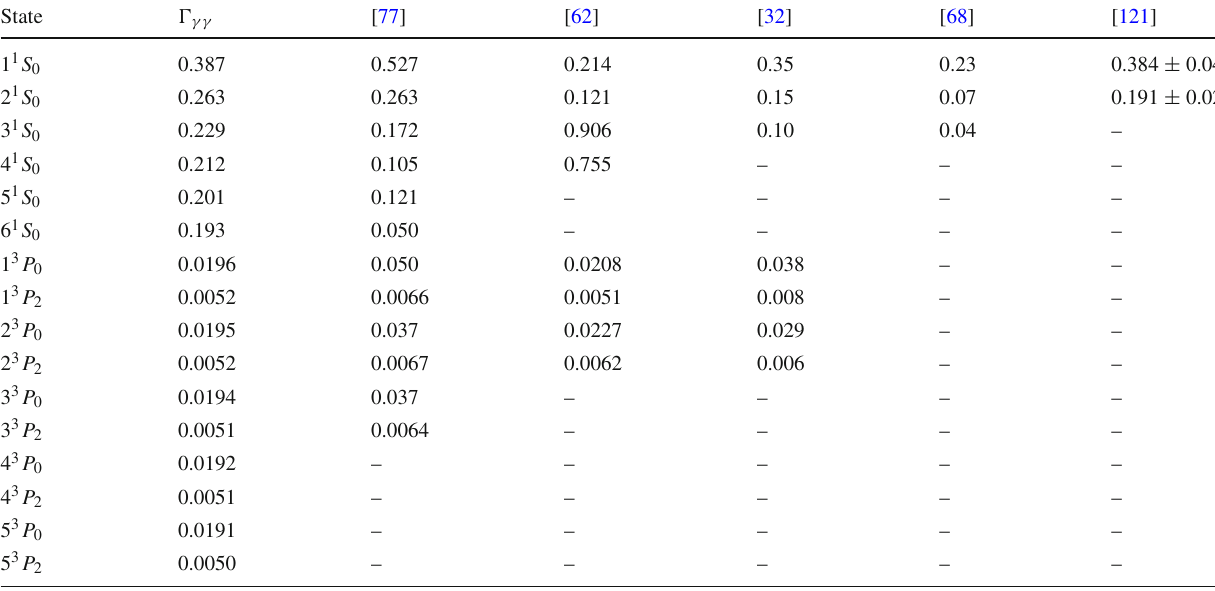
Table 15 Digamma decay width of S and P -wave bottomonia (in